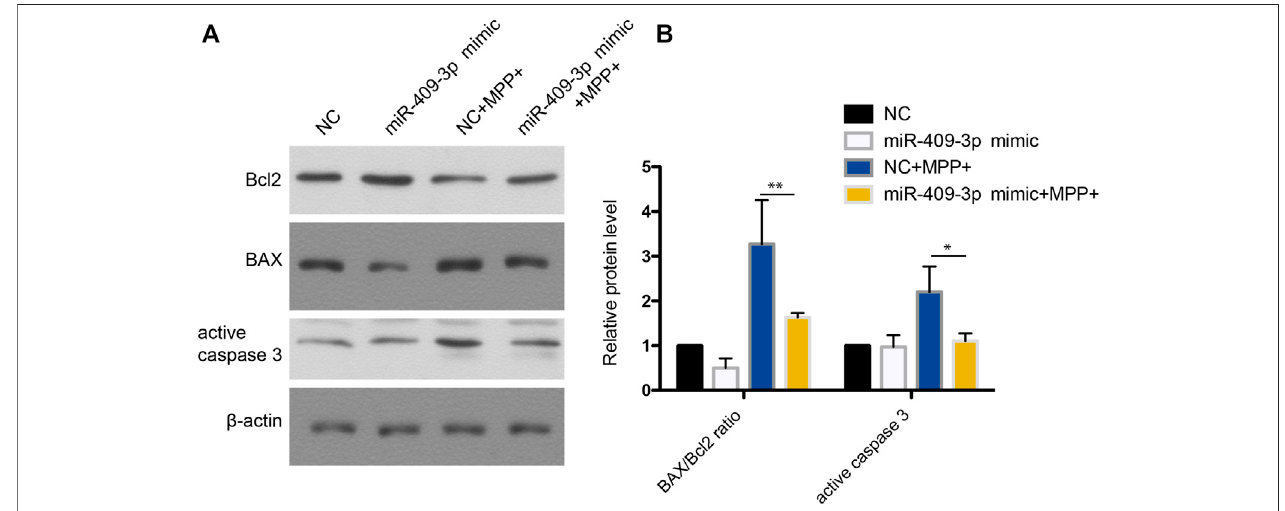
FIGURE 4 | Western blot analysis shows that miR-409-3p overexpression inhibits apoptosis. (A) The apoptosis related proteins (BAX, Bcl2 and Cleaved caspase 3) weredetectedbywesternblotanalysisinSH-SY5YcellstreatedwithMPP + aftermiR-409-3poverexpression. (B) HistogramsshowsthattheBAX/Bcl2ratioandthelevelof active caspase 3 decrease in the miR-409-3p overexpression group with MPP + -induced apoptosis. Data were analyzed using Student t -test, * p < 0.05; ** p < 0.01.